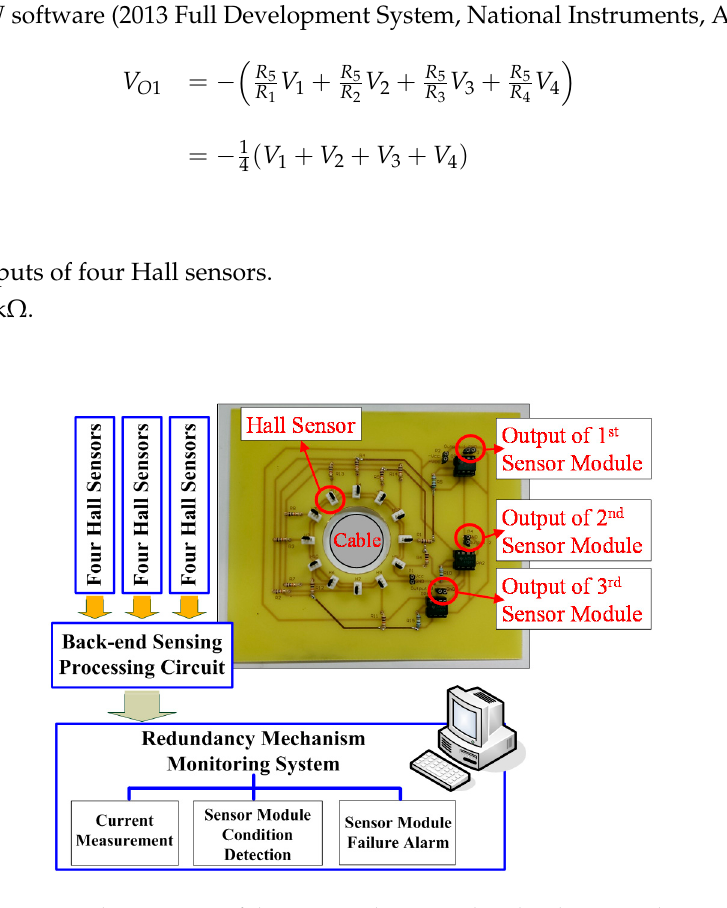
Figure 5. Implementation of the proposed HCT with redundancy mechanism.